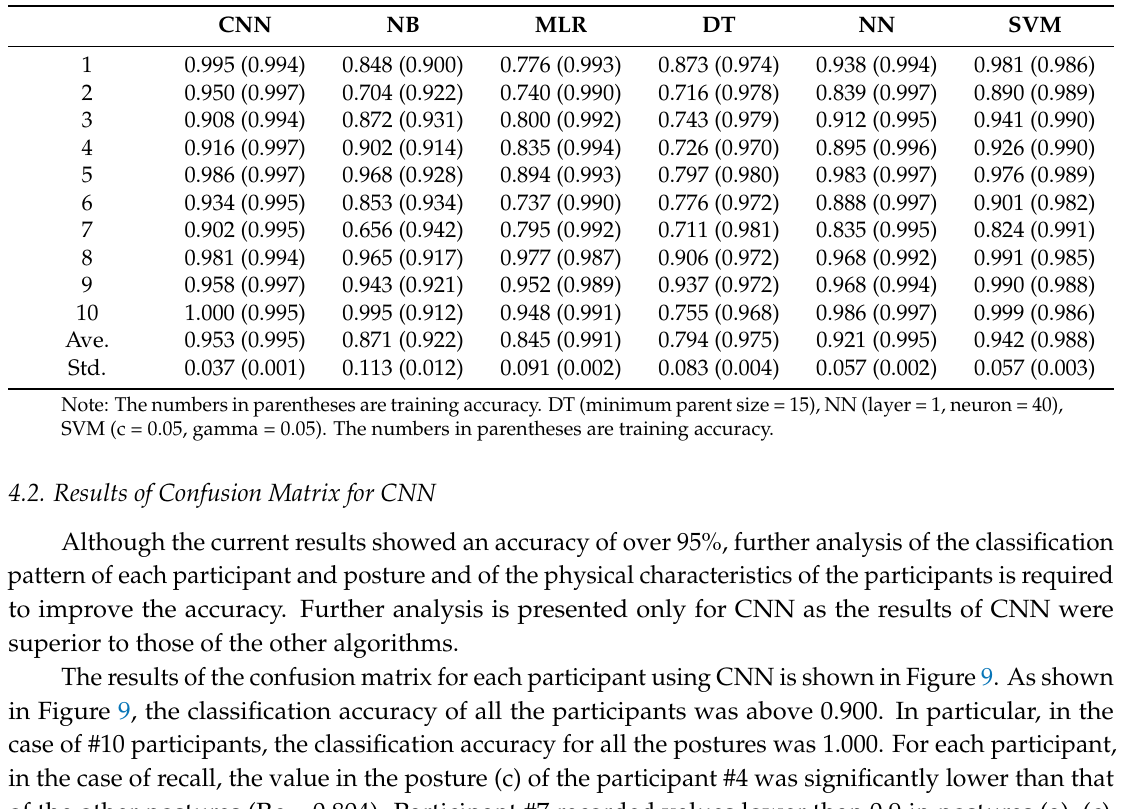
Table 4. Results of CNN along with the best performance of the other